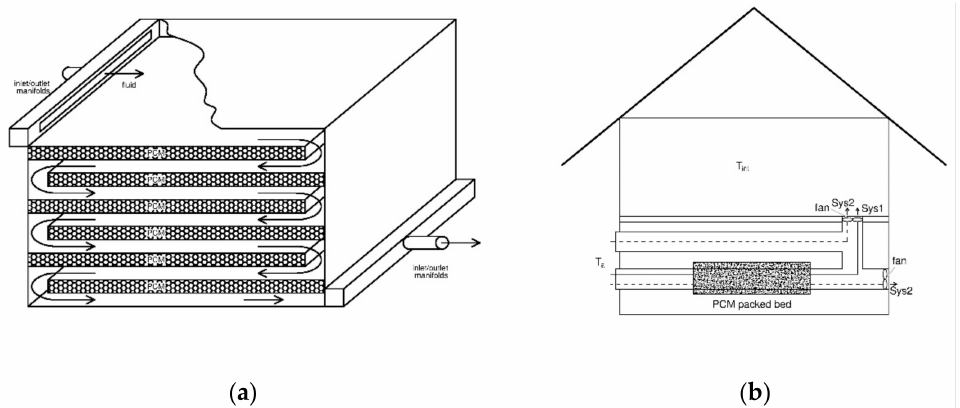
Figure 2. PCM heat storage unit: ( a ) schematic representation of plate heat storage unit [52], ( b ) scheme of storage heat exchanger with PCM packed bed